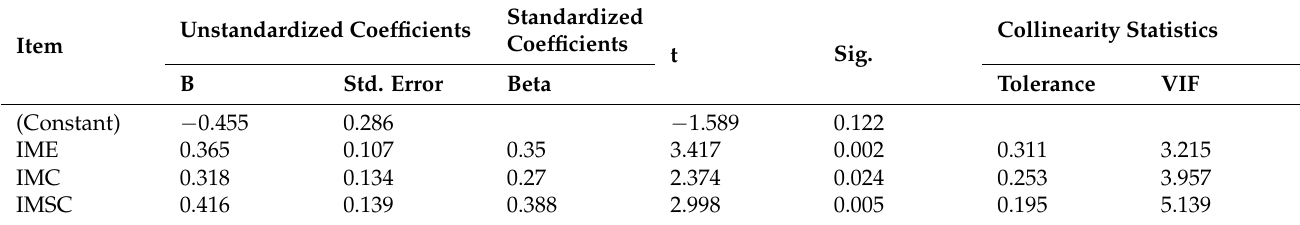
Table 4. Results of correlation analysis (dependent variable: SOL).